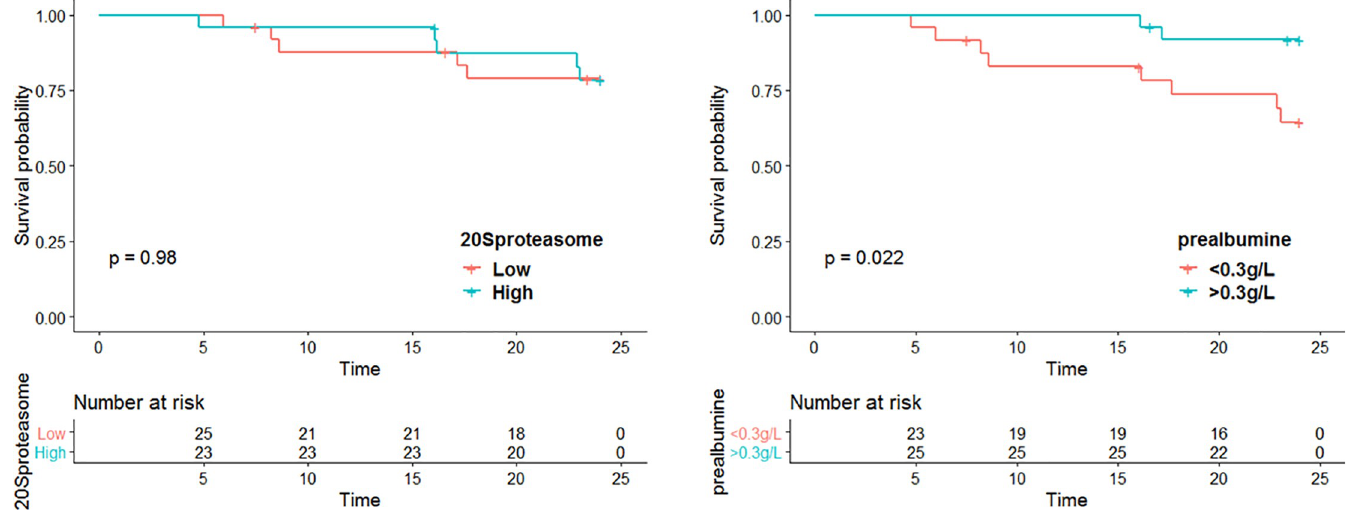
Fig 3. Two-year survival according to baseline c20S proteasome and prealbumin value. c20S proteasome, circulating 20S proteasome.